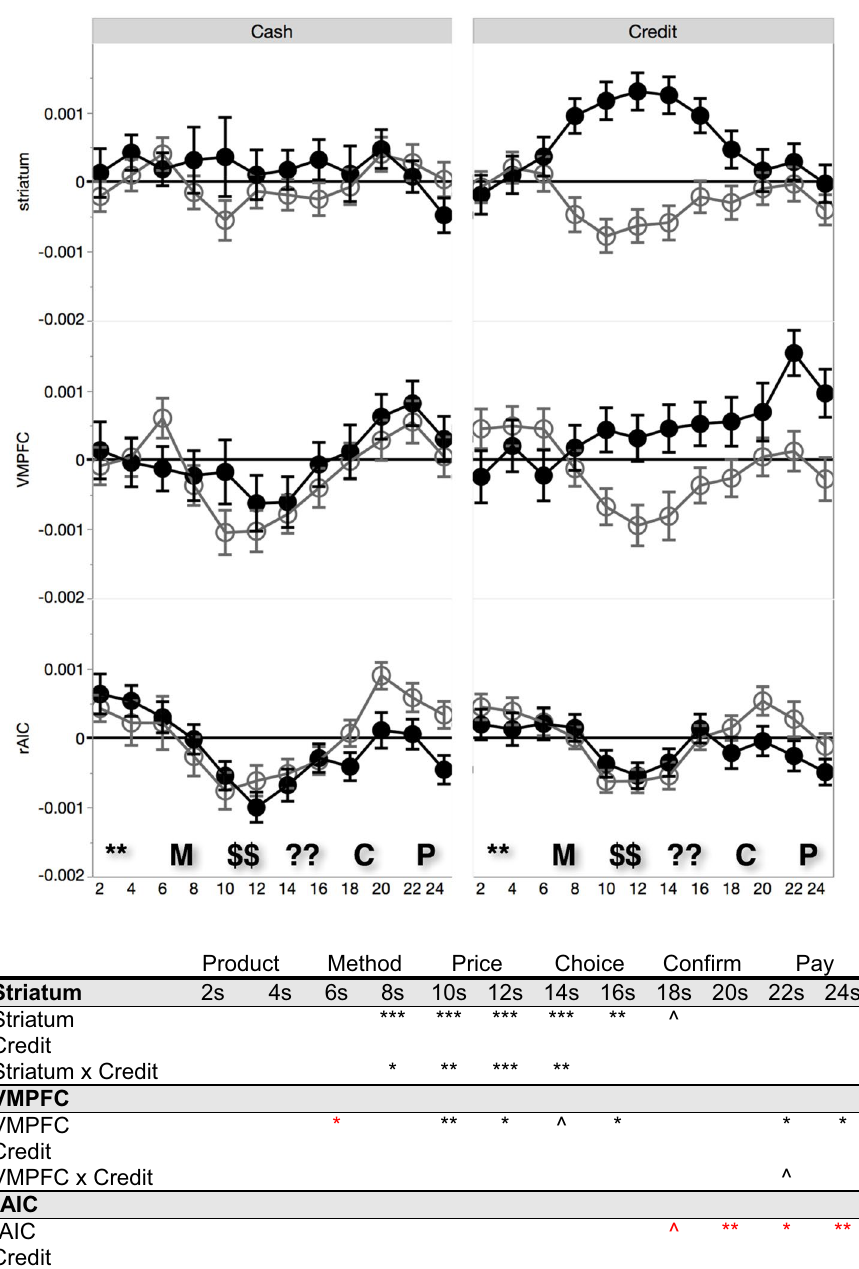
Figure 4. Above: ROI signal intensity time courses illustrating purchase (black) versus non-purchase (grey). Below: Buy decision regressed on ROI signal intensity, payment method, and interaction at each TR. Red indicates a negative coefficient. Parameter significance denoted by *** p < .001, ** p < .01, * p < .05, ^ p < .10. Phases: * = product, M = method, $ = price, ? = choice, C = confirm, P =